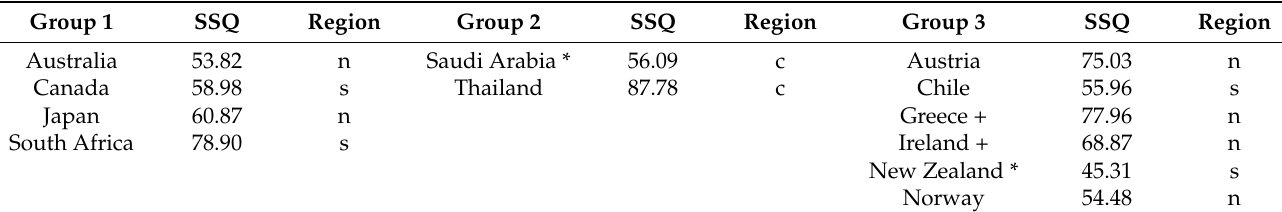
Table 2. The three groups of 12 countries in N/S Hemispheres. Group 1: large countries, Group 2: control (“c”, quasi- equatorial) countries, Group 3: smaller countries. The countries as exceptions (Saudi Arabia for indoors during summer, New Zealand for cruise ships and harsh restrictive measures are marked by an asterisk (*)—otherwise they would match Thailand and Austria, respectively). Added (non-equivalenced) countries are marked by a plus sign. All other countries in North (n) or South (s) are equivalenced, with the summary statistic sum of squares (SSQ) exhibiting similar values (irrespective of the shape of the normalized difference distribution). Available as Data Supplement 2